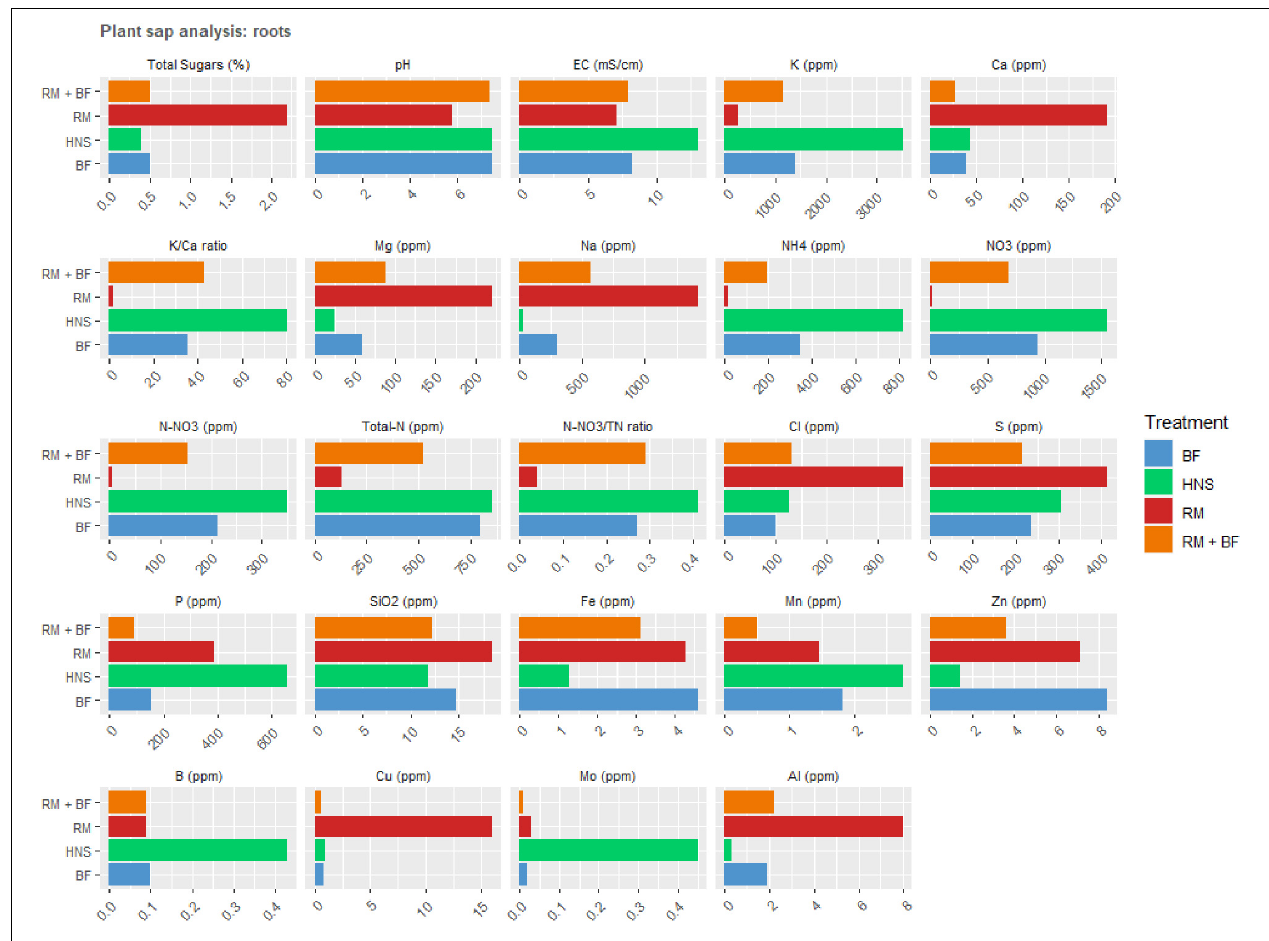
FIGURE 9 | Plat sap analysis of the roots at